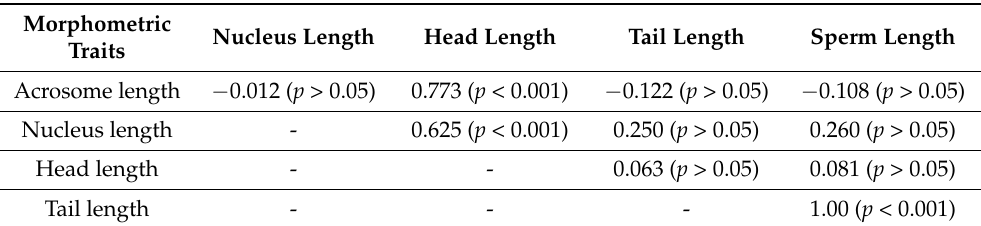
Table 4. Pearson coefficients (r) showing correlation between the morphometric dimensions of drone spermatozoa